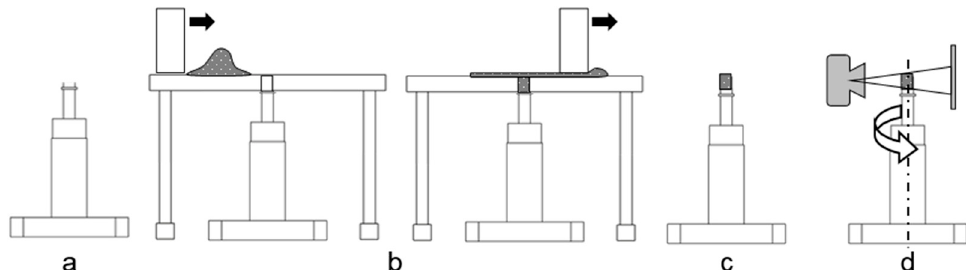
Figure 8. ( a ) Insert with mount for X-ray micro computed tomography (XMT); ( b ) insert with powder deposition plate and powder application; ( c ) insert with cover; ( d ) tomography process.